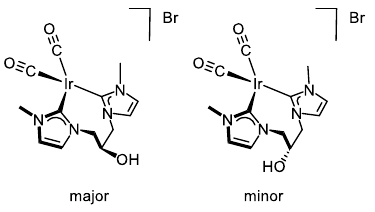
Figure 8. Diastereomers of complex 5 .